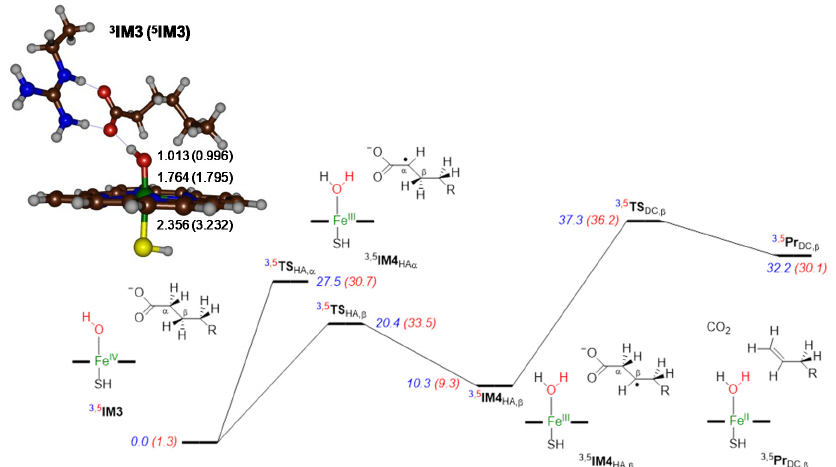
Figure 6. Optimized geometry of the iron(IV)-hydroxo substrate complex as potential intermediate in the catalytic cycle of P450 OleT JE with bond lengths in angstroms. The potential energy landscape of substrate decarboxylation by 3,5 IM3 with energies ( Δ E+ZPE values) in kcal mol ‒ 1 .